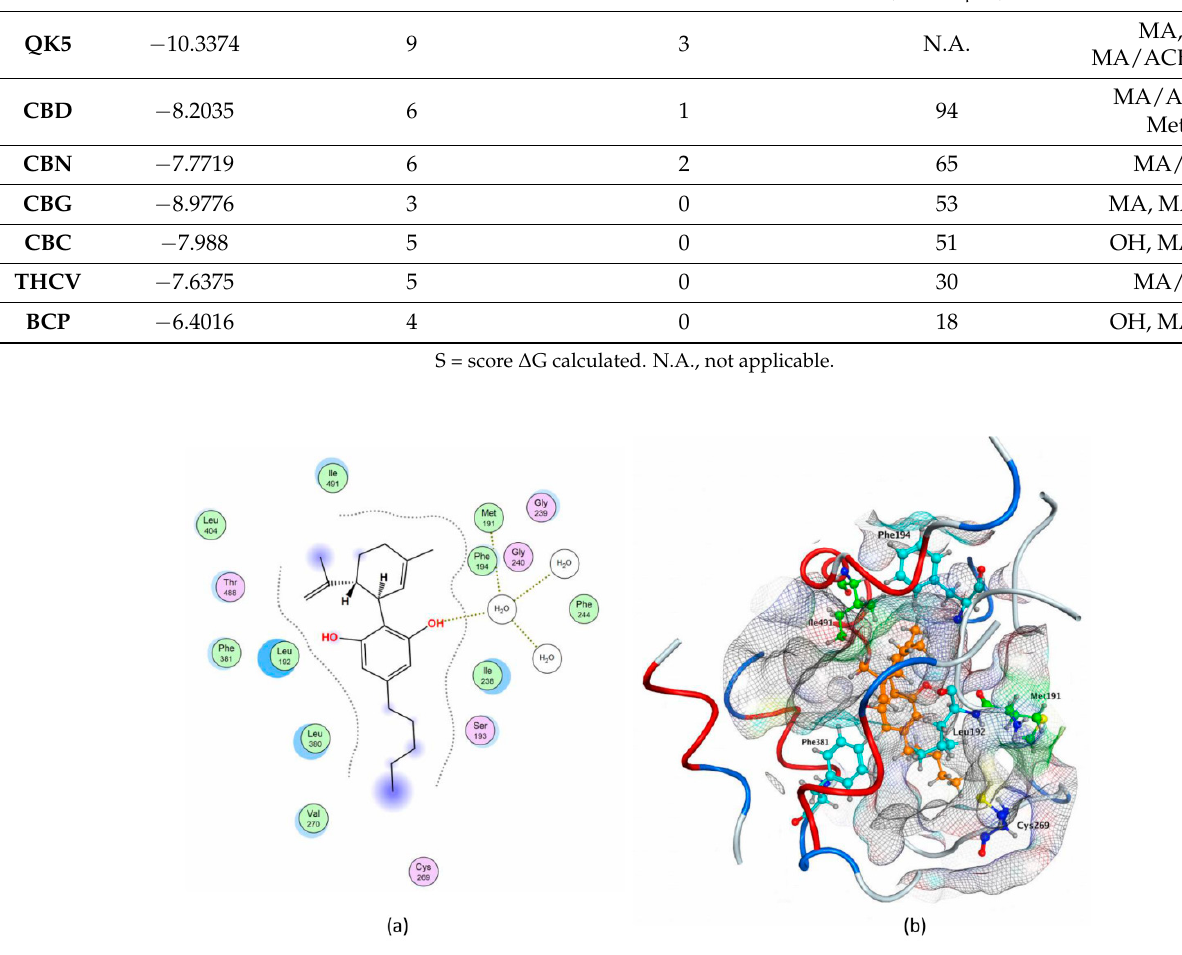
Table 5. Summary of in silico and in in vitro results on the interaction of tested cannabis-derived compounds with rFAAH. S (Kcal/Mol) Total Key Interactions Polar Key Interactions